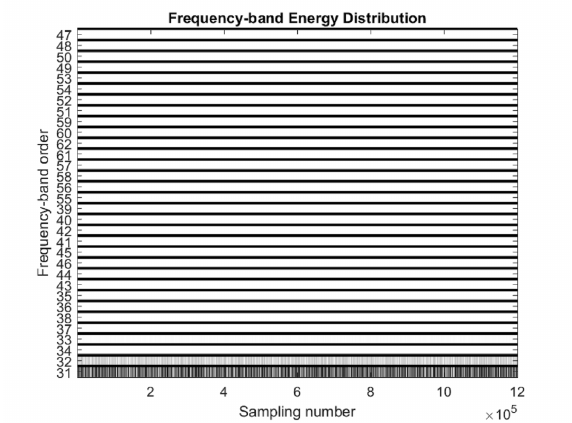
Figure 7. Frequency-band energy distribution at the initial stage of processing.